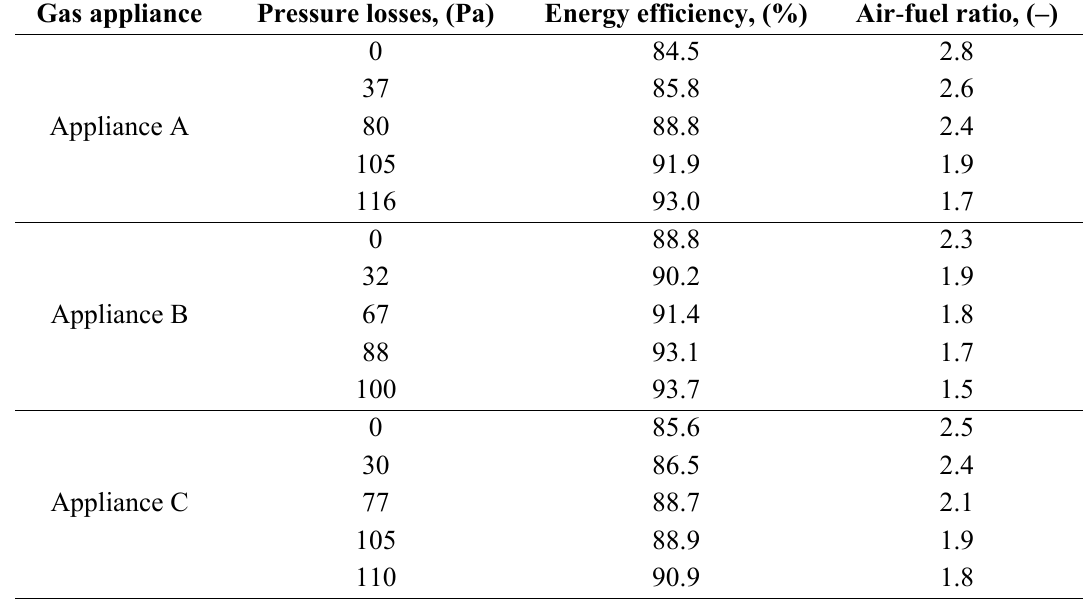
Table 3. Examination results of pressure losses influencing energy efficiency of various